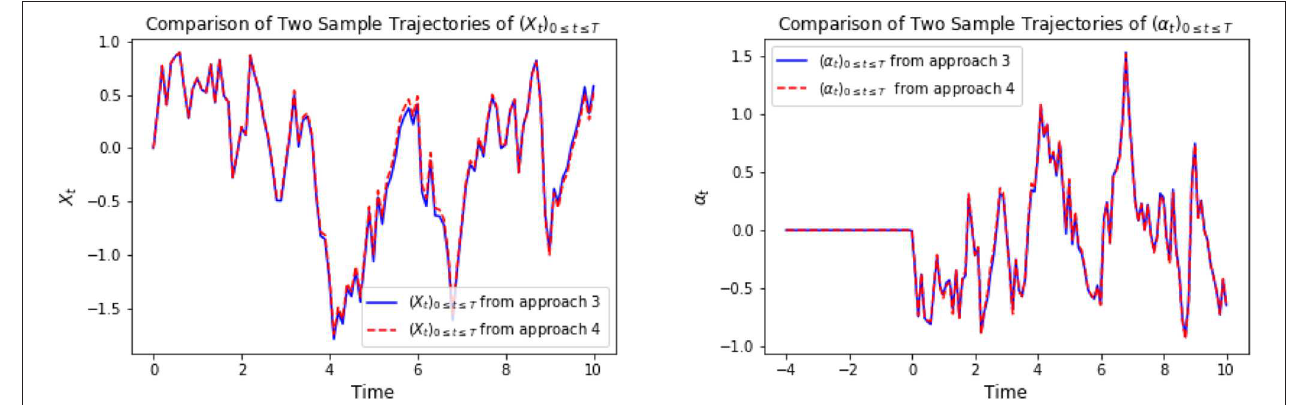
) t . The plot on the right shows the comparison of one representative optimal i 0 ≤ t i ≤ t N